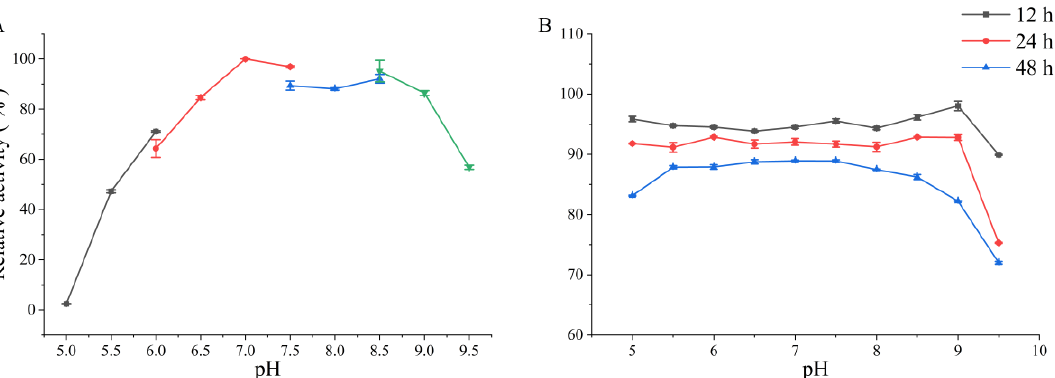
Figure 4. Effects of pH on the enzymatic activity of the novel alginate lyase (PMD). ( A ) Effect of pH on the enzymatic activity of PMD (grey: sodium citrate buffer, pH 5.0–6.0; red: phosphate buffer, pH 6.0–8.0; blue: Tris-HCl buffer, pH 7.5–8.5; green: glycine-NaOH buffer, pH 8.5–9.5); ( B ) pH stability of PMD.